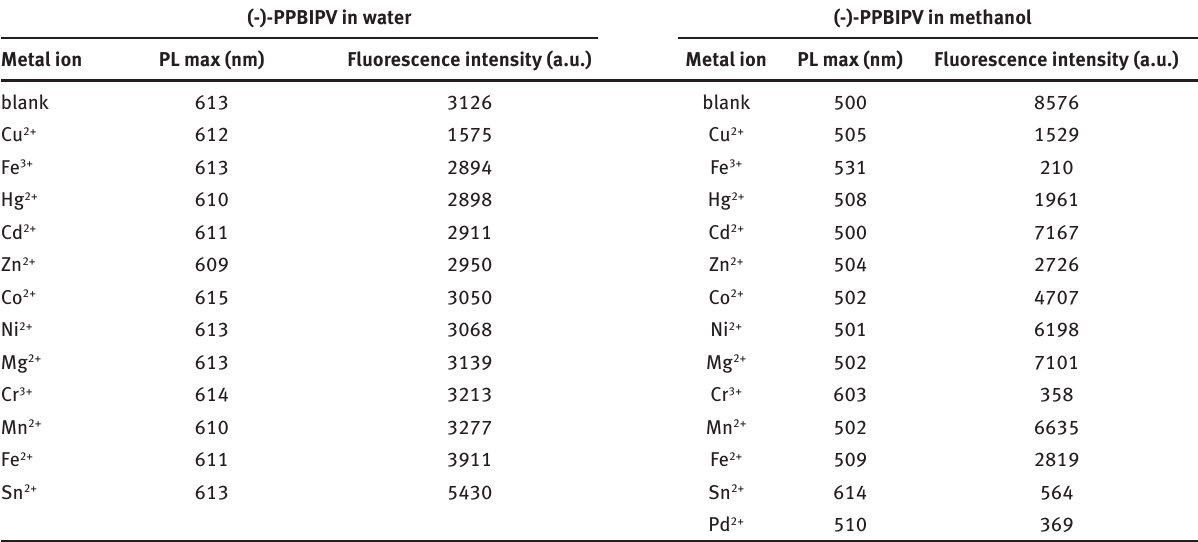
Table 3: PL max (nm) and maxima of fluorescence intensity of (-)-PPBIPV with different metal ions. (-)-PPBIPV in water (-)-PPBIPV in